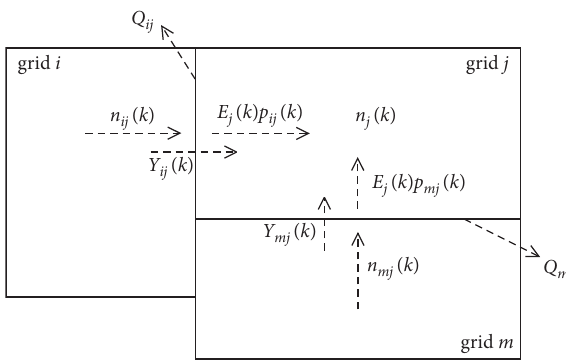
Figure 4: The influencing factors of S